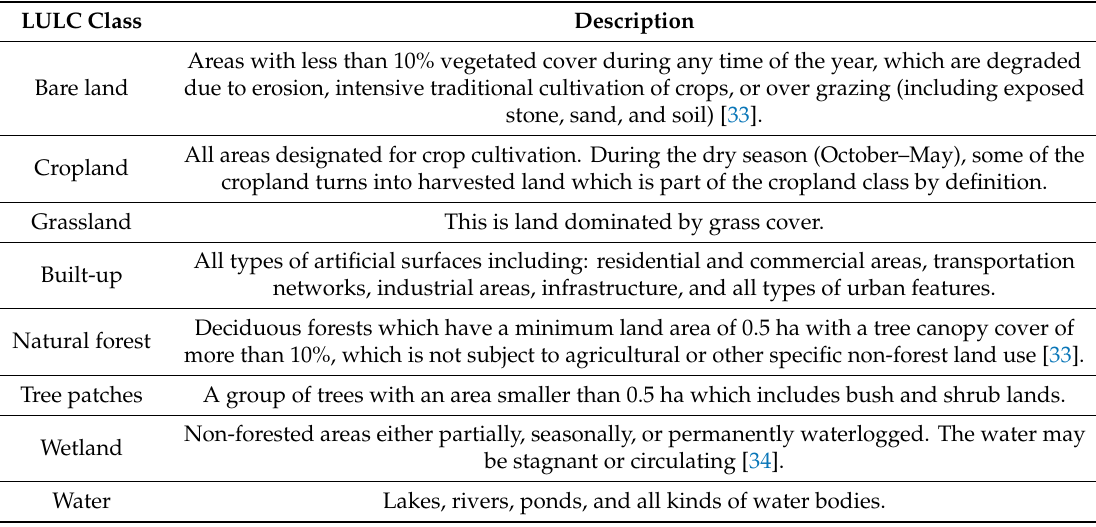
Table 1. Description of land use / land covers classes used for change study from 1985 to